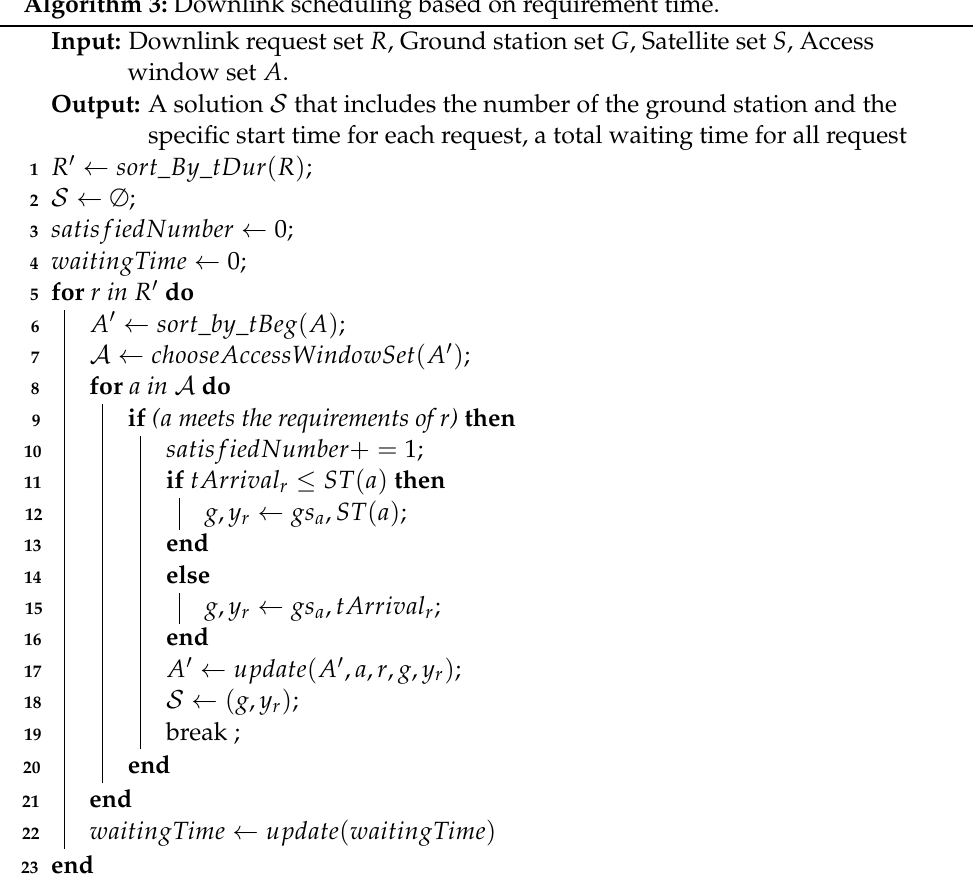
Algorithm 3: Downlink scheduling based on requirement